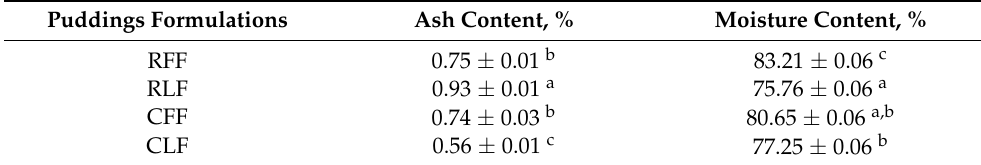
Table 2. Ash (%) and moisture (%) content of puddings formulations (RFF—rice starch, peach pur é e; fruit).